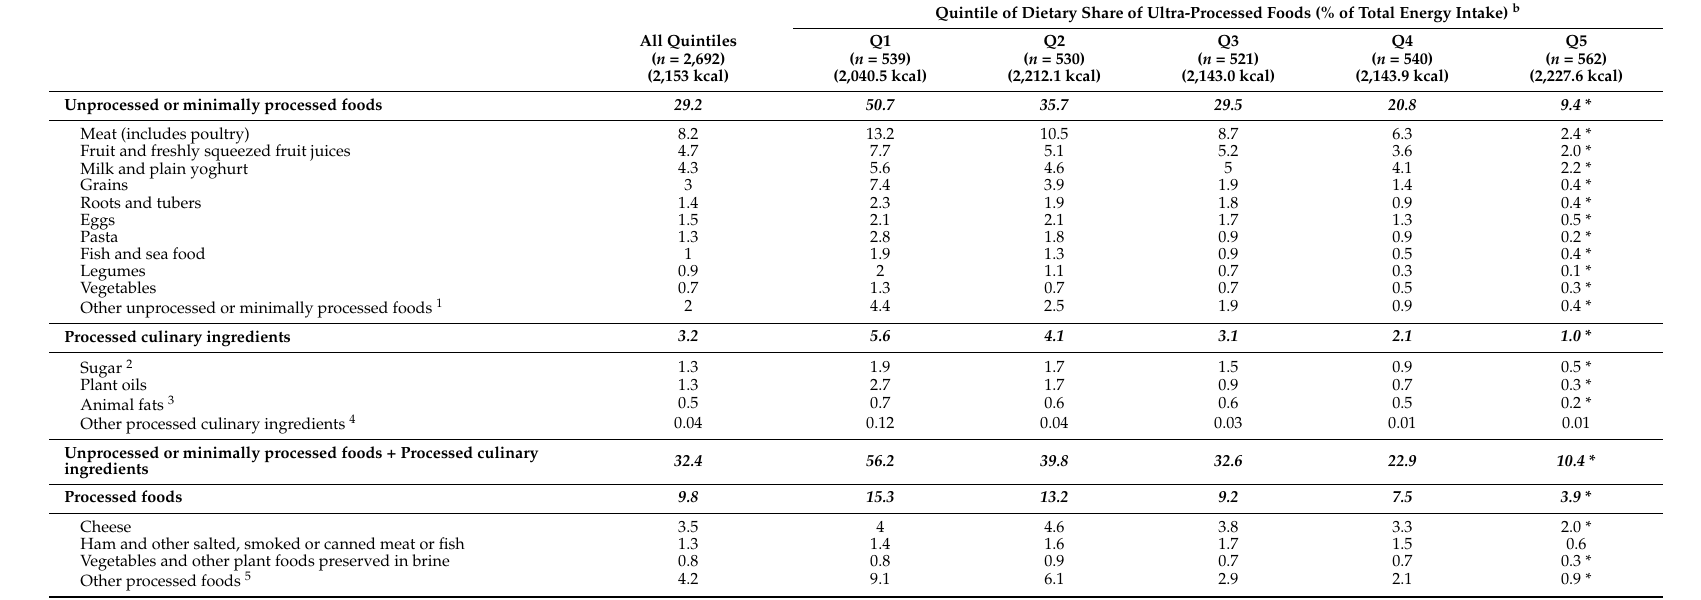
Table 1. Distribution (%) of the total daily per capita energy intake (kcal) according to NOVA food groups by quintiles of the dietary share of ultra-processed foods a